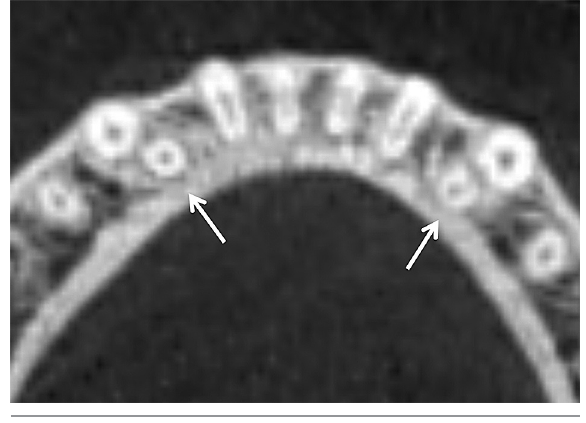
Figure 3. Axial section showing bilateral two-rooted canines